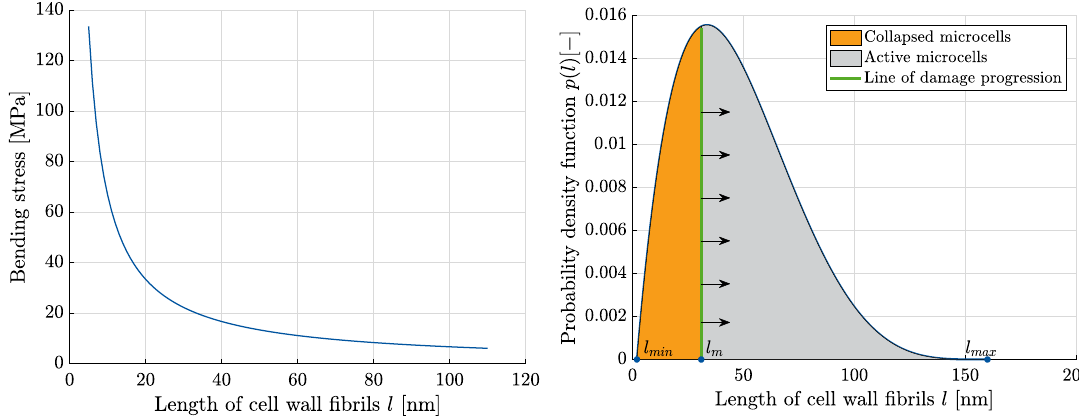
Figure 7. Left : Maximal bending stress versus the cell wall fibril size, for example, for λ = 0.95. Right : An illustration of the cell-size distribution. The area under the curve encompasses the microcells in the network. Accordingly, with progressive damage, the number of collapsed microcells